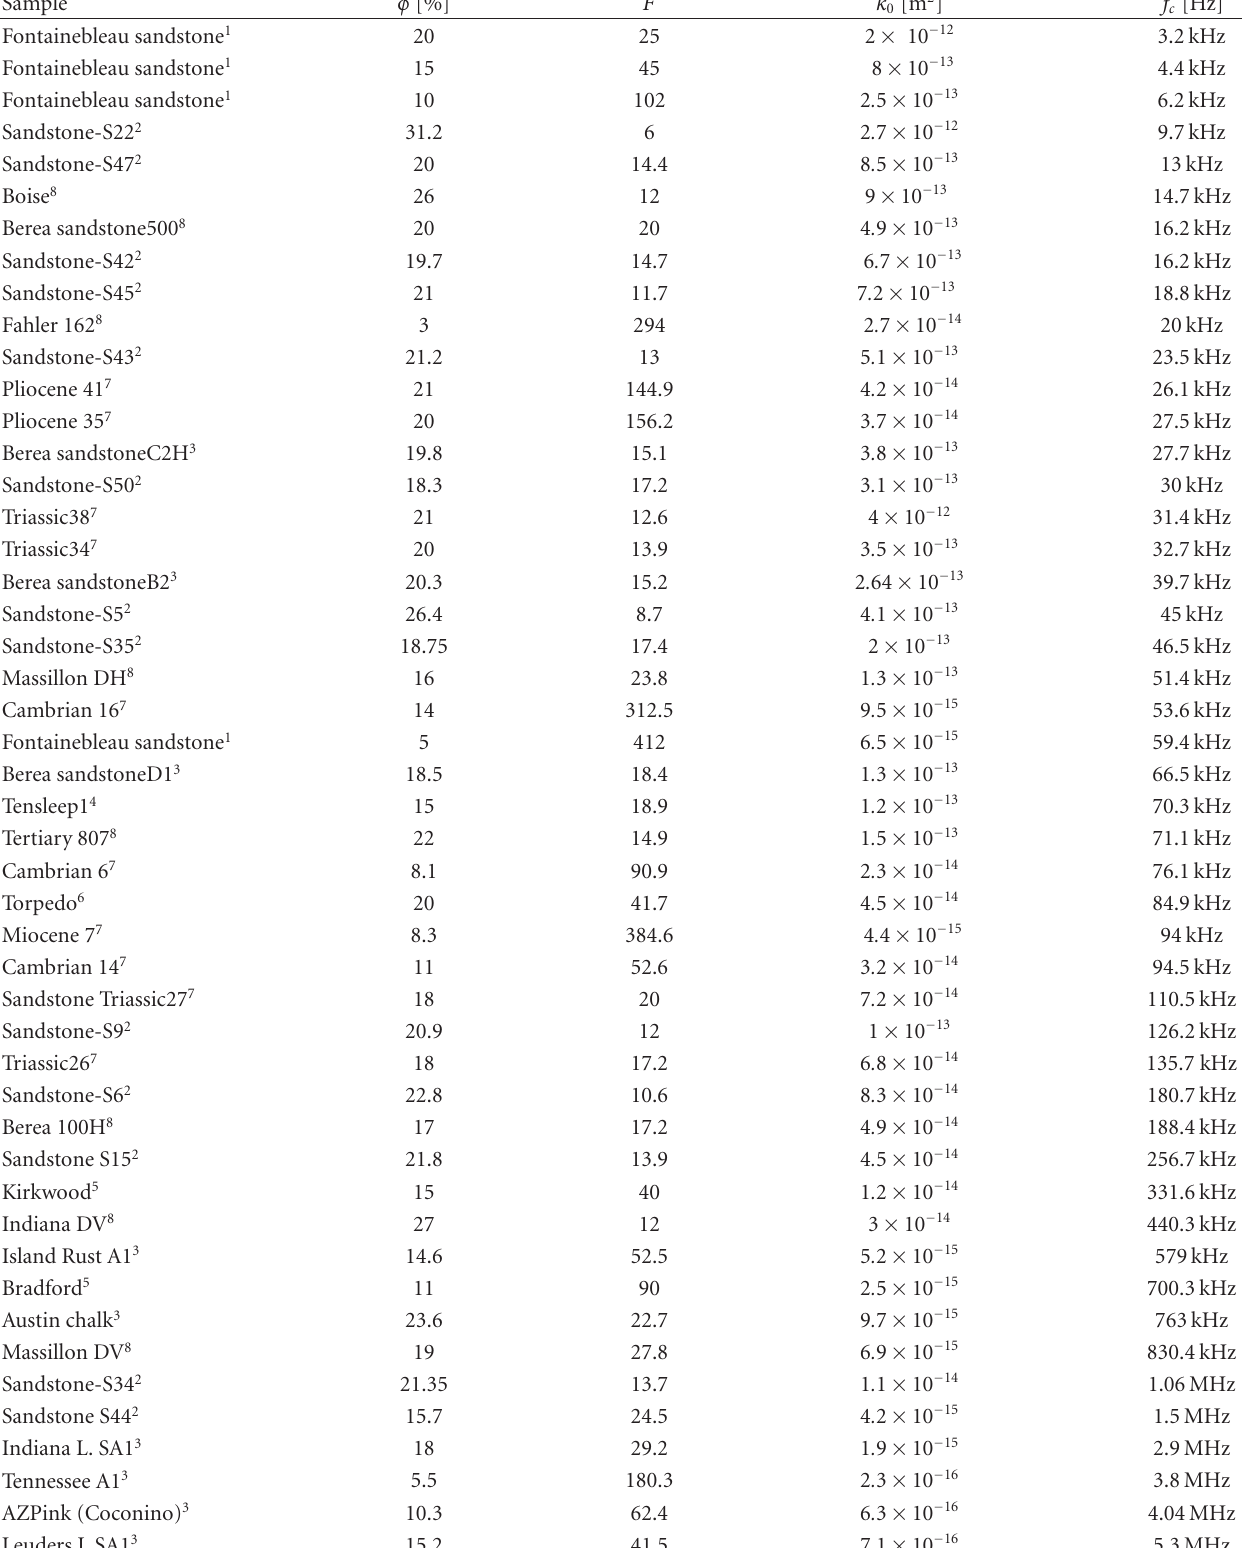
Table 2: Predicted transition frequency (from (11)), for dynamic streaming potential, for samples of porosity φ , formation factor F , and permeability k 0 , from (1) calculated in the present study, and measured by (2) Taherian et al. [67], (3) Morgan et al. [68], (4) Fatt [69],